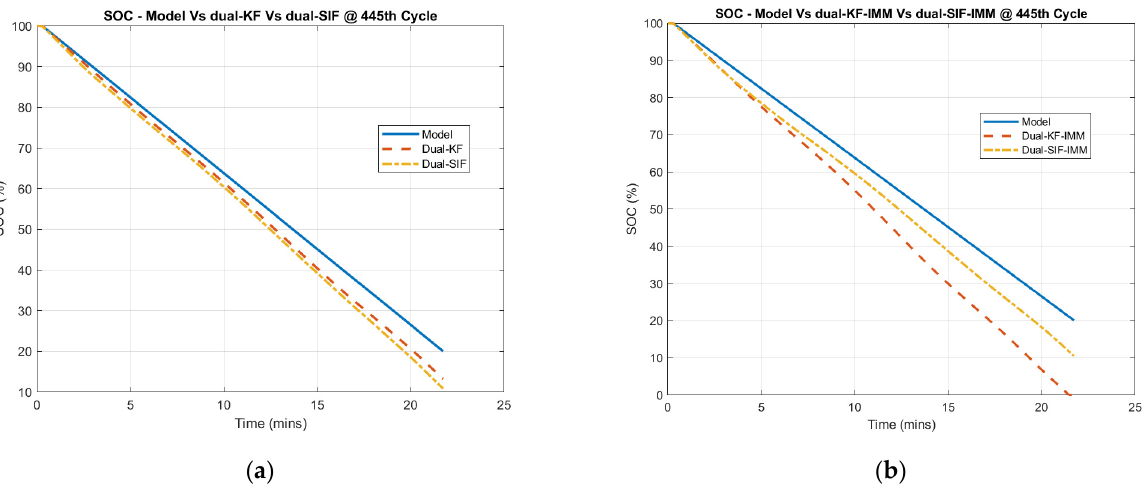
Figure 17. ( a ) Dual-KF and dual-SIF SOC estimates at cycle 445. ( b ) Dual-KF-IMM and dual-SIF-IMM SOC estimates at cycle 445. Table 5. B034 RMSE: Battery Capacity Estimation.